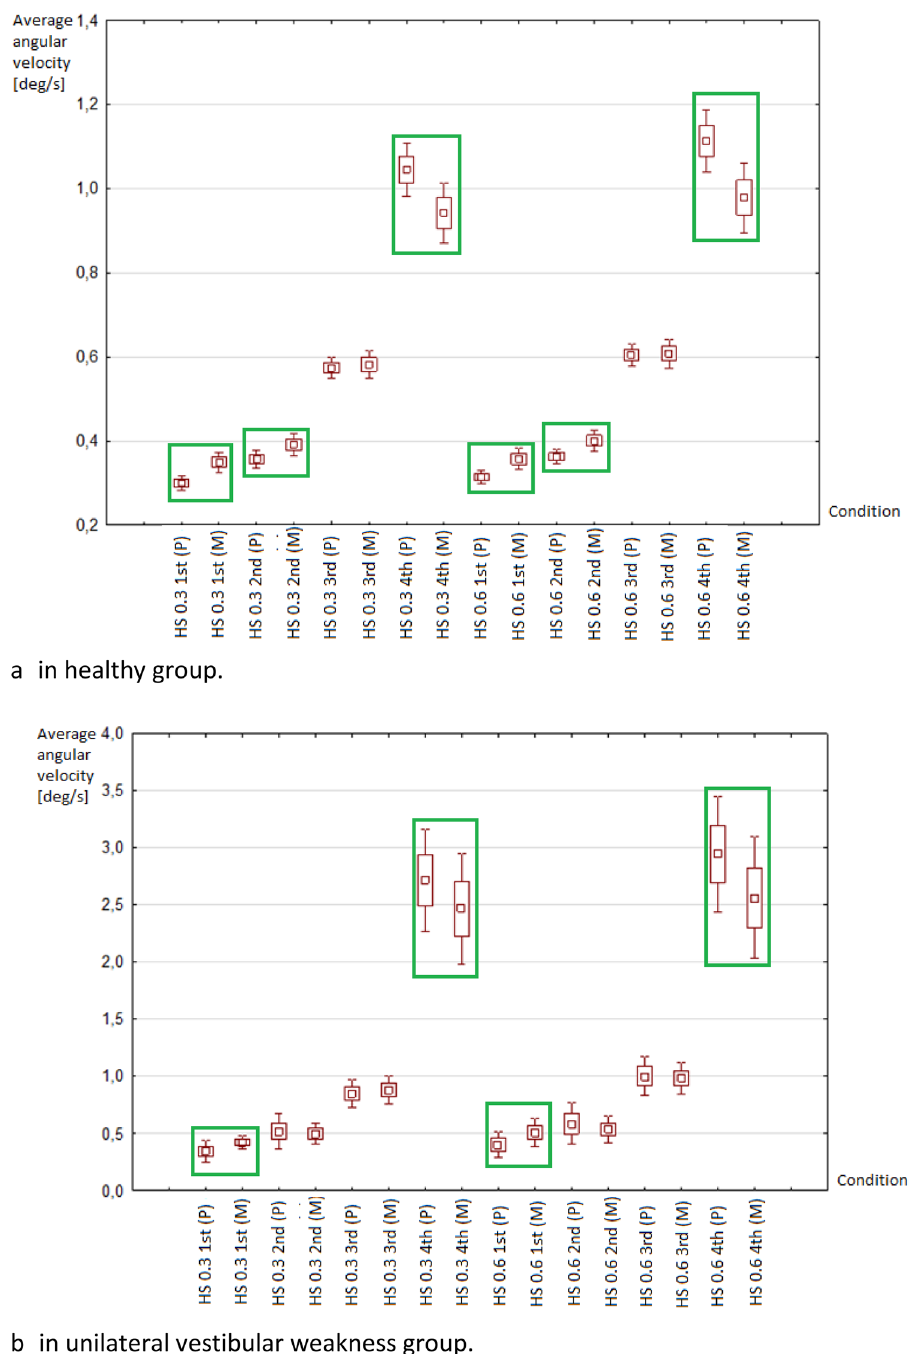
Figure 3. Distribution of average angular velocity values of the posturographic platform (P) and MediPost (M). HS 0.3—posturography with head frequency movements 0.3 Hz, HS 0.6—posturography with head movements at a frequency of 0.6 Hz; Conditions: 1st (eyes open/stable surface), 2nd (eyes closed/stable surface), 3rd (eyes open/foam), 4th (eyes closed/foam); P posturography platform, M MediPost (accelerometer device). Green boxes mark the statistically different mean values between the force plate and MediPost (p <